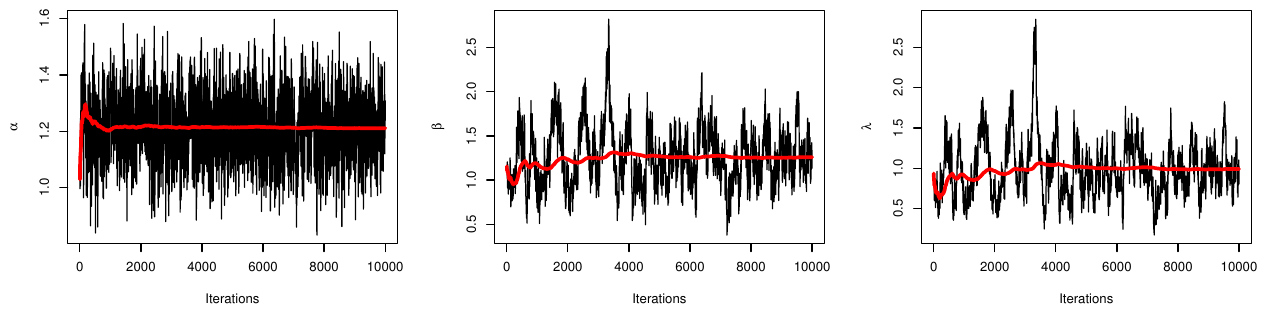
Figure 11. Trace plot of MCMC results for parameters of UEPD for the milk production data.